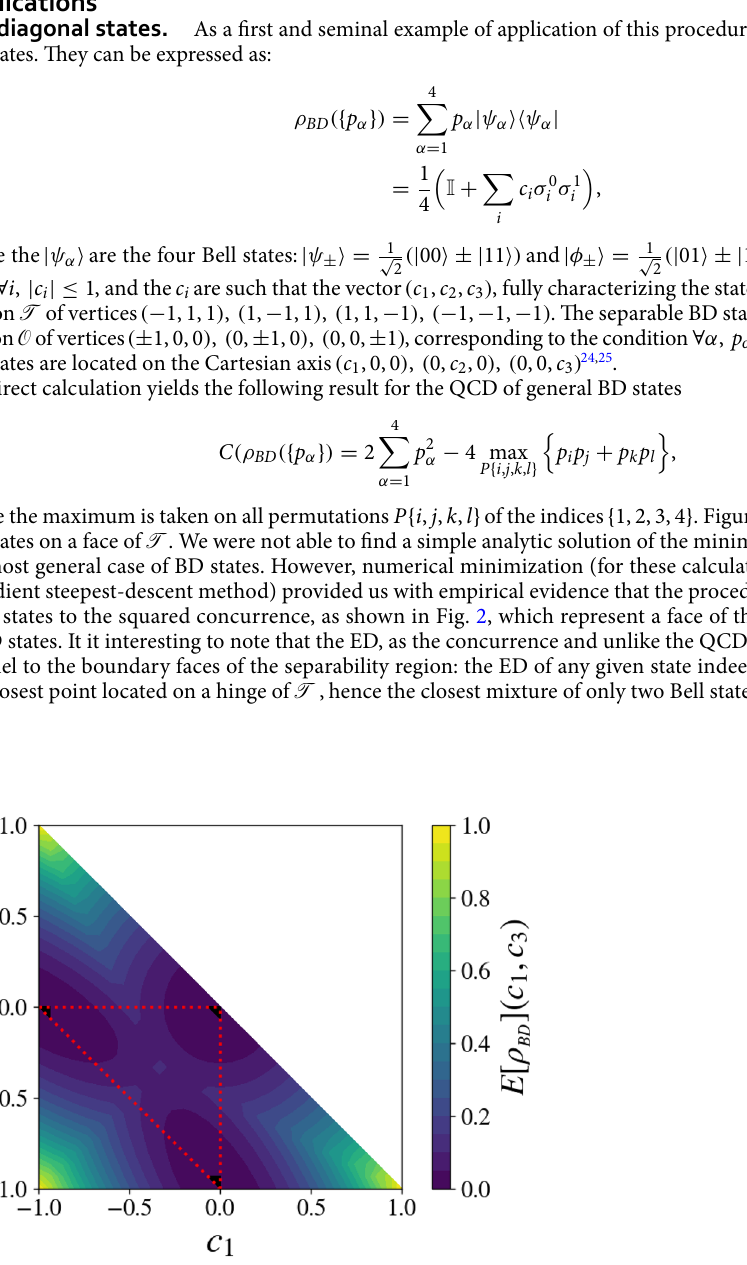
ρ BD ( c 1 , c 2 c 1 , c 3 )/ 2 for a face of the BD state tetrahedron T , Figure 1. Quantum correlations C [ ] = corresponding to a mixture of three Bell states. The red dotted line defines the smaller triangle where the state is separable, according to the PPT criterion 26,27 . The vertices of the large triangle correspond to pure Bell states. Those of the red dotted triangle, of vanishing QCD, correspond to equal-weight mixtures of two Bell states, which are evidently the three only classical states in the represented